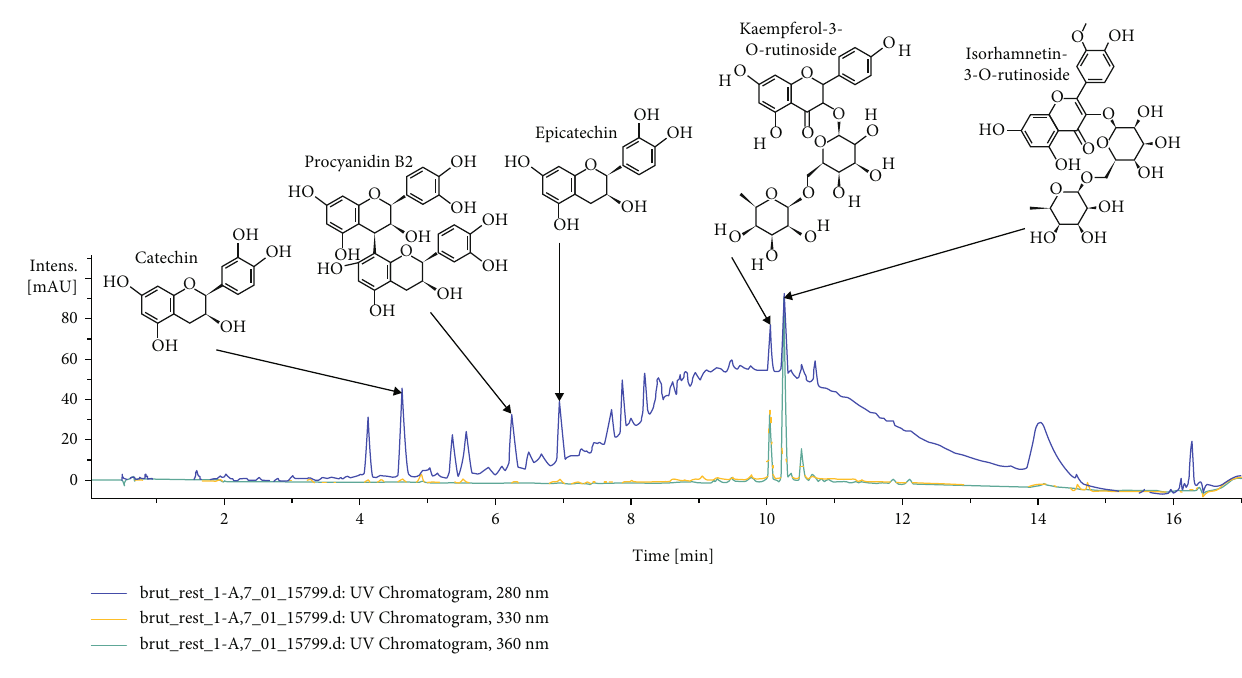
Figure 2: UPLC chromatogram of phenolic compounds in almond